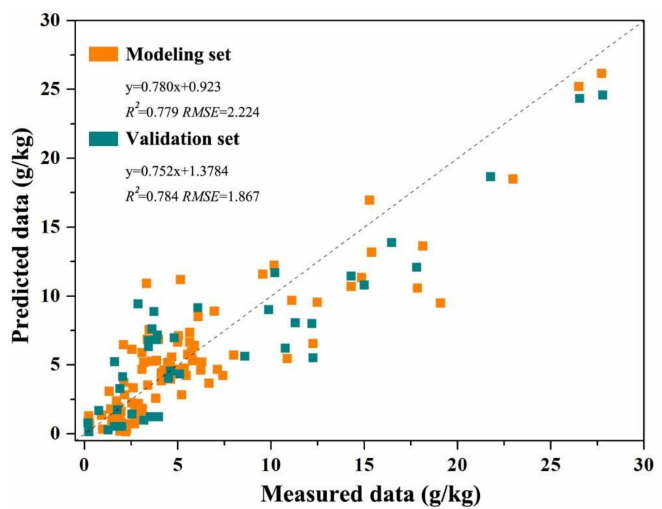
Figure 2. Scatter plot of the optimal retrieval model (SSRI-based RF method) of soil salinity based on UAV